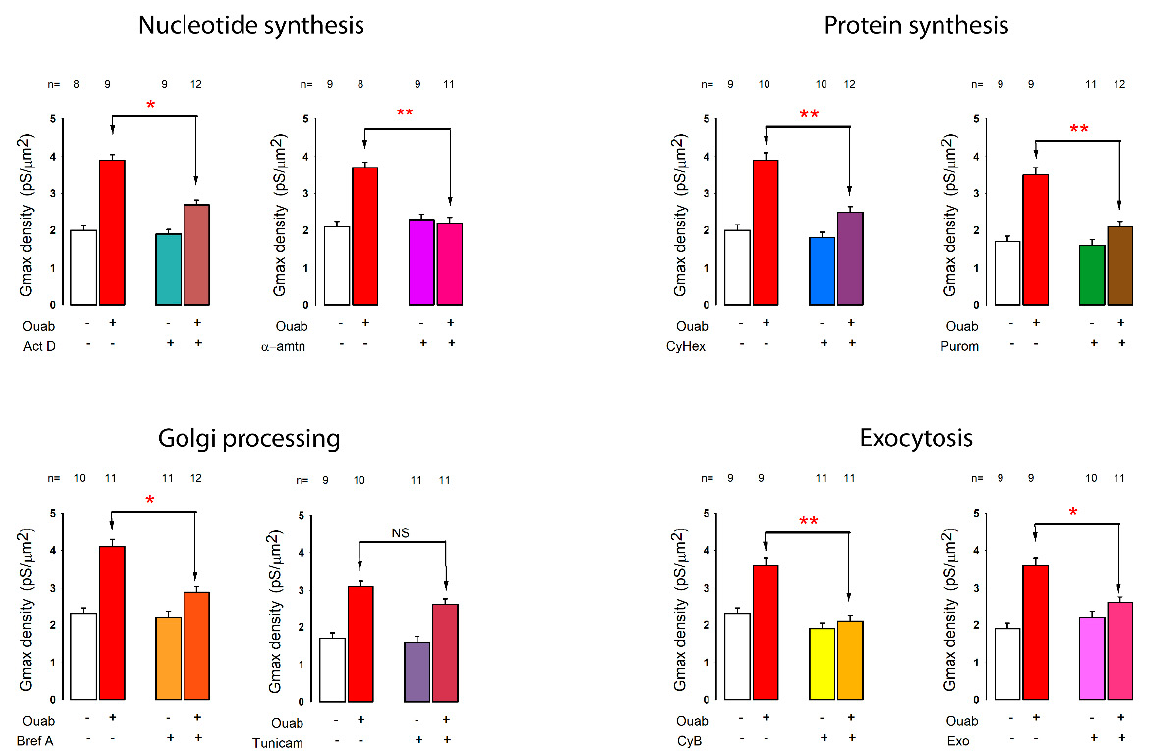
Figure 7. The effect of inhibitors on the synthesis, assembly and export of new proteins involved in the increase in potassium conductance density, caused by ouabain, in cells in mature monolayers. Each bar graph shows the mean ( ± SE) value of δ G max , obtained from current records of individual cells in MEMs, which were treated or not with ouabain for 6 hours and treated or not with the different inhibitors as indicated at the bottom of the bars. The number of repetitions in each group is indicated above each bar. Asterisks indicate a statistically significant difference between the groups indicated by the arrows. (*) indicates a p < 0.05 and (**) p < 0.001. Abbreviations: Act D = actinomycin D, α -amnt = α -amantidin, CyHex = cycloheximide, Purom = puromycin, Bref A = brefeldine A, Tunicam = tunicamicin, CyB = cytochalasine B. NS: no